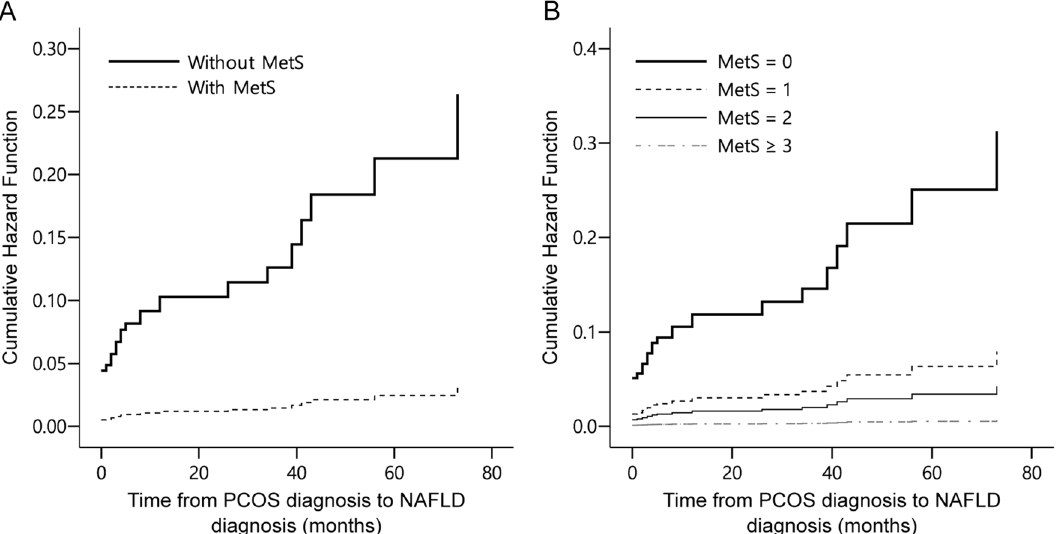
Figure 4. Cox regression analysis of non-alcoholic fatty liver disease diagnosis since polycystic ovary syndrome diagnosis ( a ) according to metabolic syndrome (MetS) diagnosis and ( b ) according to the number of MetS components in Korean